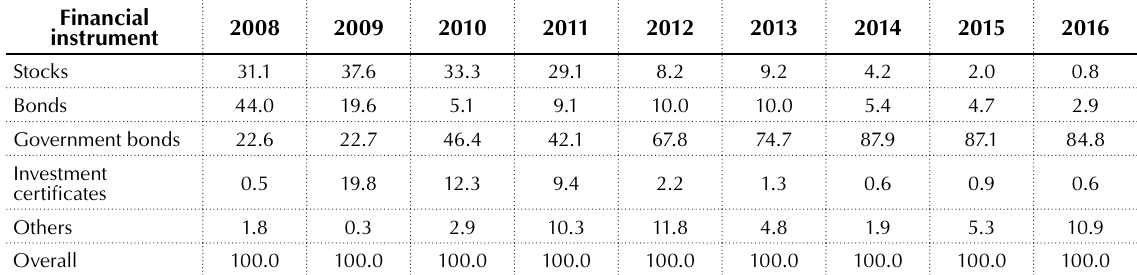
Table 2. Structure of the Ukrainian stock market by financial instruments in 2008–2016, % Financial